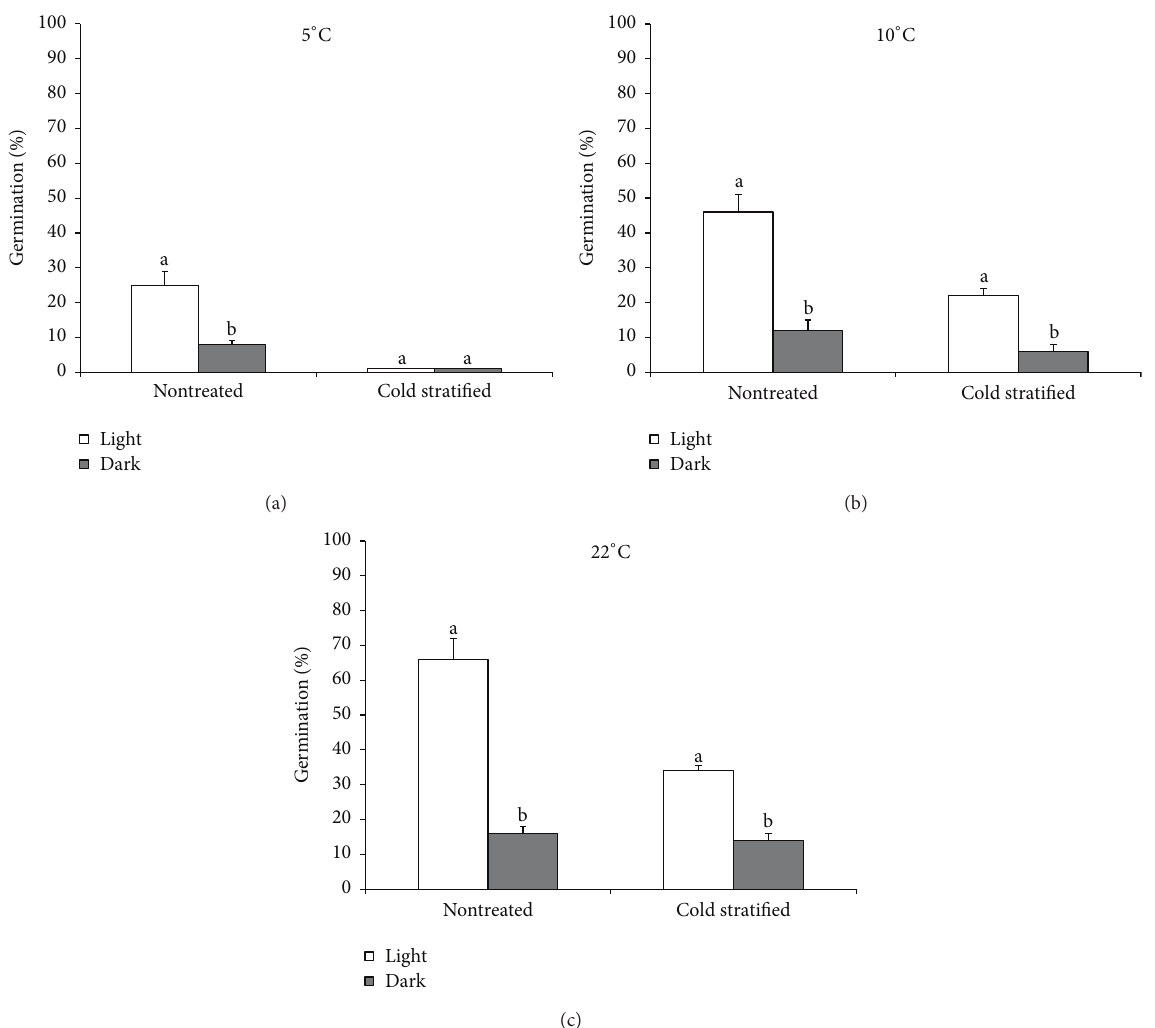
Figure 2: Effects of temperature and light condition on germination as recorded for nontreated and cold-stratified seeds of Rumex confertus . Different lower-case letters indicate significant differences in germination percentages of the same treatment between light and dark periods at 5 ∘ C (a), 10 ∘ C (b), and 22 ∘ C (c) for 20 days (Tukey’s test at 𝑃 < 0.05 ). Each value is a mean of four replicates of 25 seeds. Error bars indicating standard